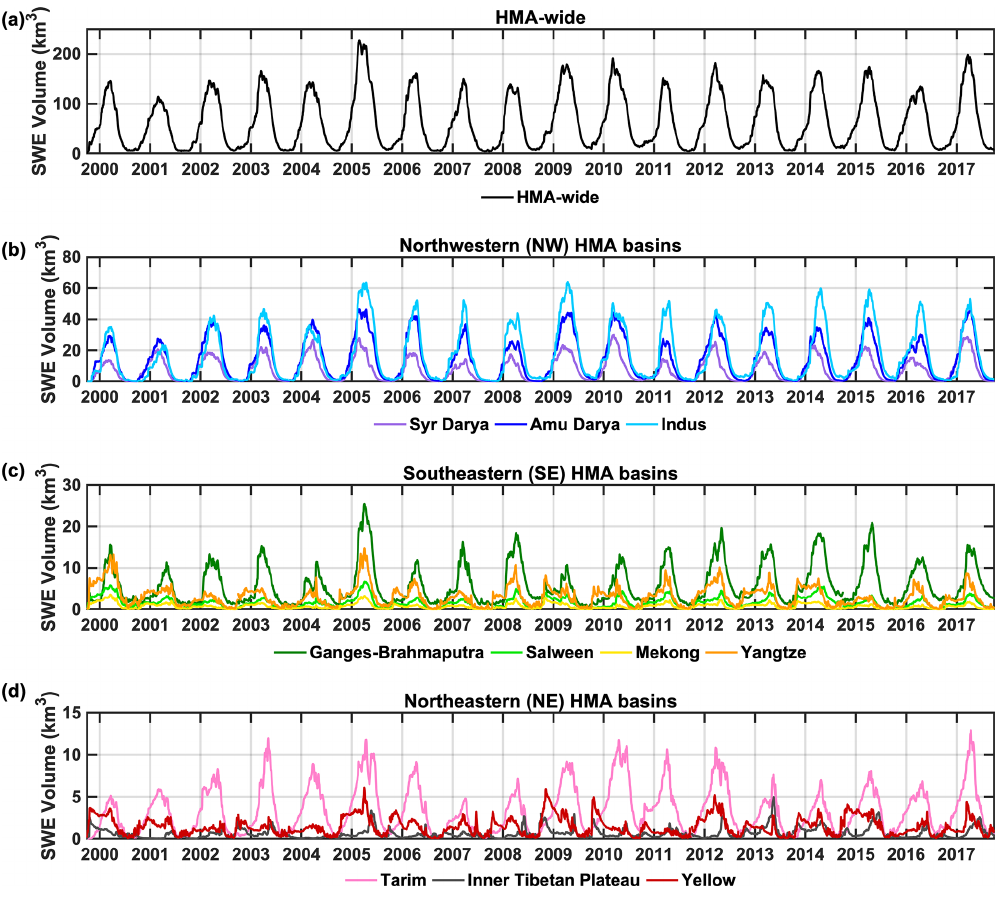
Figure 7. Daily time series of seasonal SWE volumes aggregated to (a) HMA-wide, (b) northwestern (NW), (c) southeastern (SE) and (d) northeastern (NE) basin